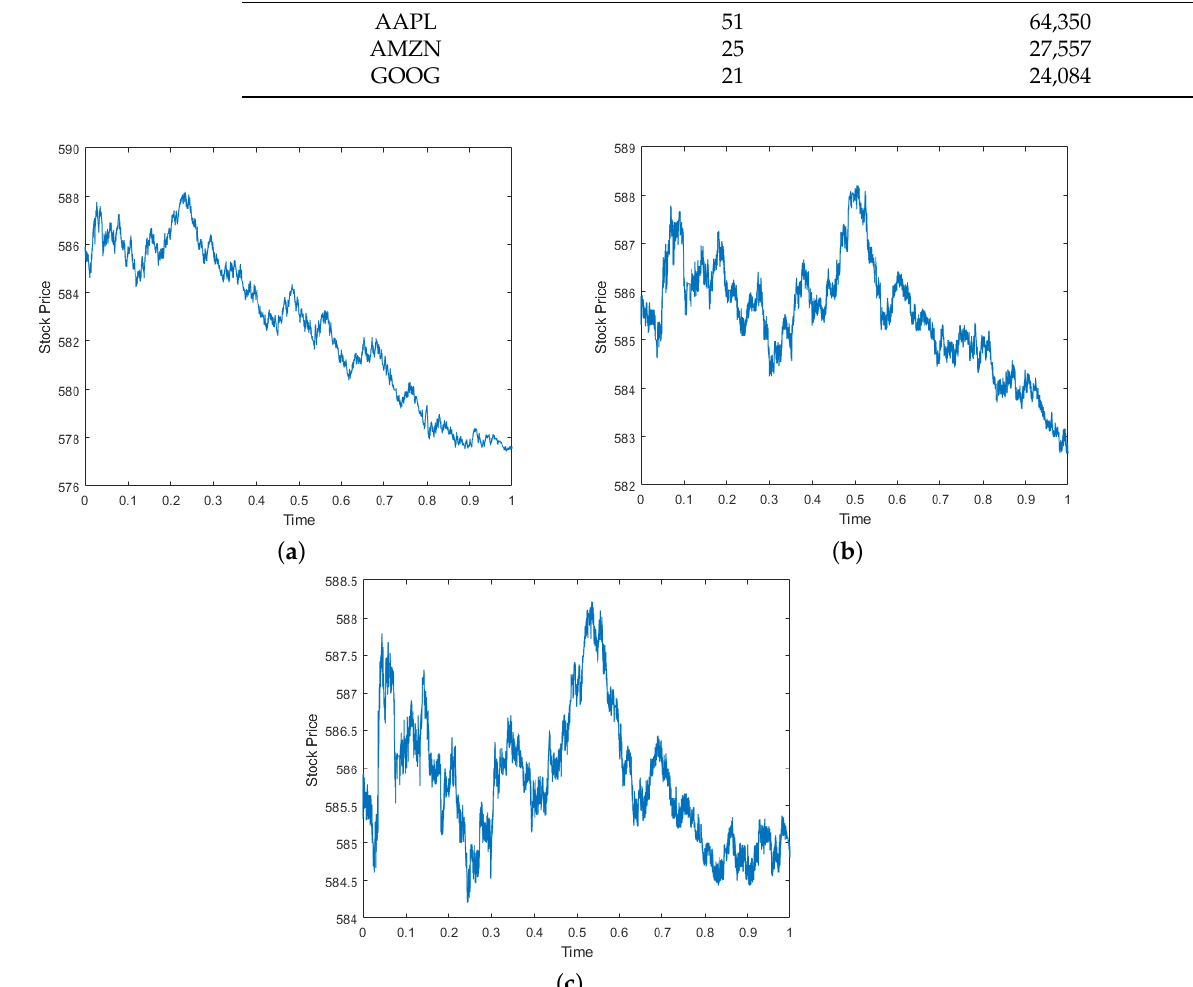
Figure 1. Apple stock price, Amazon stock price, and Google stock price. The three figure above show the the observed stock price on 21 June 2012, from LOBster data. ( a ) Apple stock price; ( b ) Amazon stock price; ( c ) Google stock